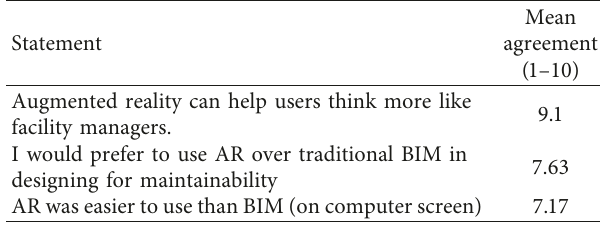
Table 9: Postquestionnaire-perception results. Table 10: Alternative visualization questionnaire